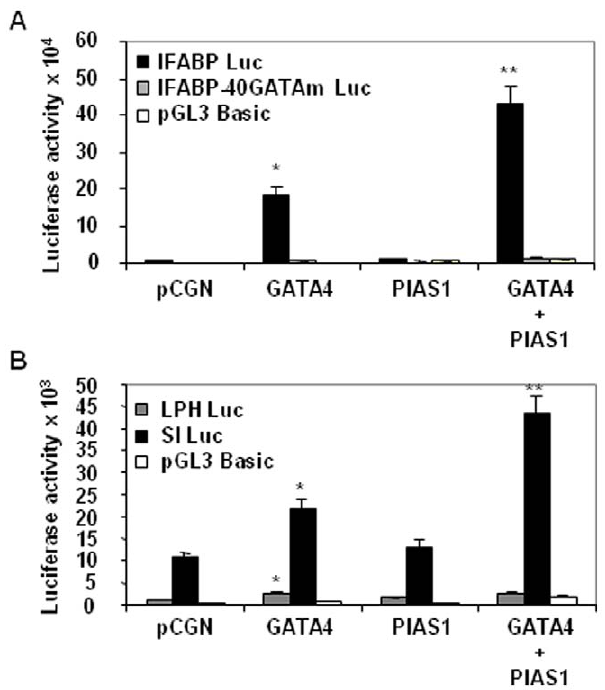
Figure 4. GATA4 and PIAS1 selectively coactivate GATA4 target promoters. Subconfluent HCT116 cells were transfected with pCGN empty vector or GATA4 or PIAS1 or GATA4 and PIAS1 together along with IFABP promoter or IFABP promoter with mutated GATA4 binding site or pGL3 basic luciferase reporters ( panel A ). In panel B , LPH promoter and SI promoter luciferase reporters were used. Lysates were assayed for luciferase activity 48 hours post-transfection. Results from 3 experiments done in triplicates are shown as mean 6 SEM. *p , 0.05 for GATA4 transfected cells compared with pCGN transfected cells. **p , 0.05 for GATA4 and PIAS1 cotransfected cells compared with GATA4 transfected cells.